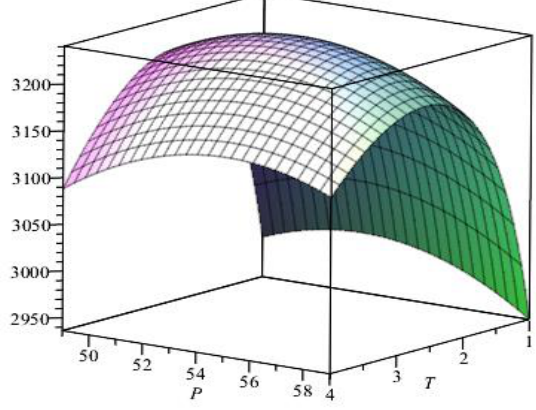
Fig. 1. Concavity of profit